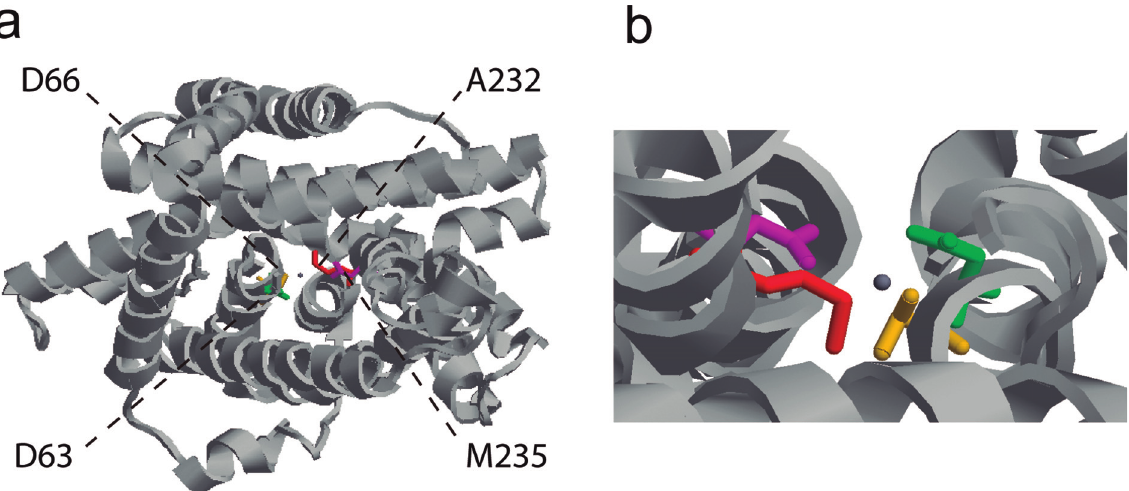
Figure 5 - Predicted 3D structure of NRAMP transporter. Tertiary structure of PvNRAMP7 predicted by SWISS-MODEL software based on the tem- plate S. capitis DMT1 (ID: 4wgw.1). (a) The ribbon structure is shown in gray, the amino acids coordinating with manganese (II) ion (shown in blue) are